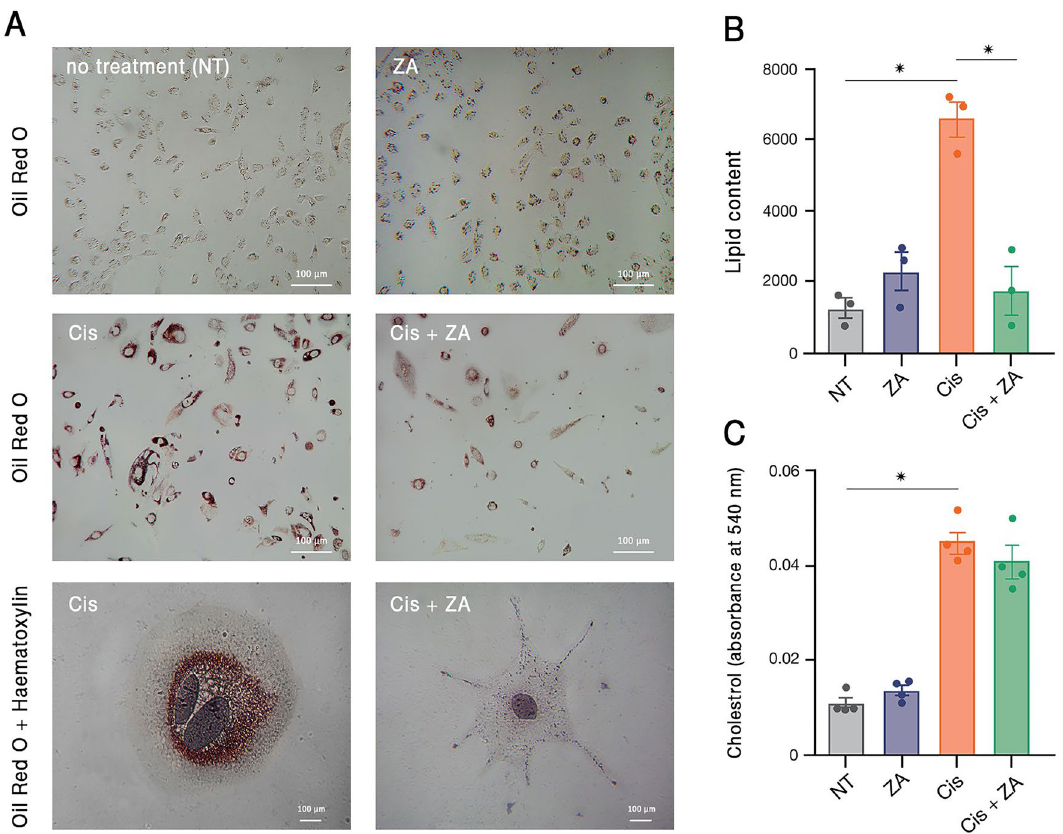
Figure 4. PGCCs have augmented lipid metabolism. ( A ) Oil Red O staining demonstrated the accumulation of lipid droplets in PGCCs surviving after cisplatin treatment which partly declined after ZA treatment. Nuclei are stained with haematoxylin. ( B ) Quantification of the red signals in the images of Oil Red O-stained cells in three independent experiments confirmed the microscopic observations. ( C ) Total cholesterol content of cancer cells increased after cisplatin treatment. * p- value < 0.05; error bars: mean ±